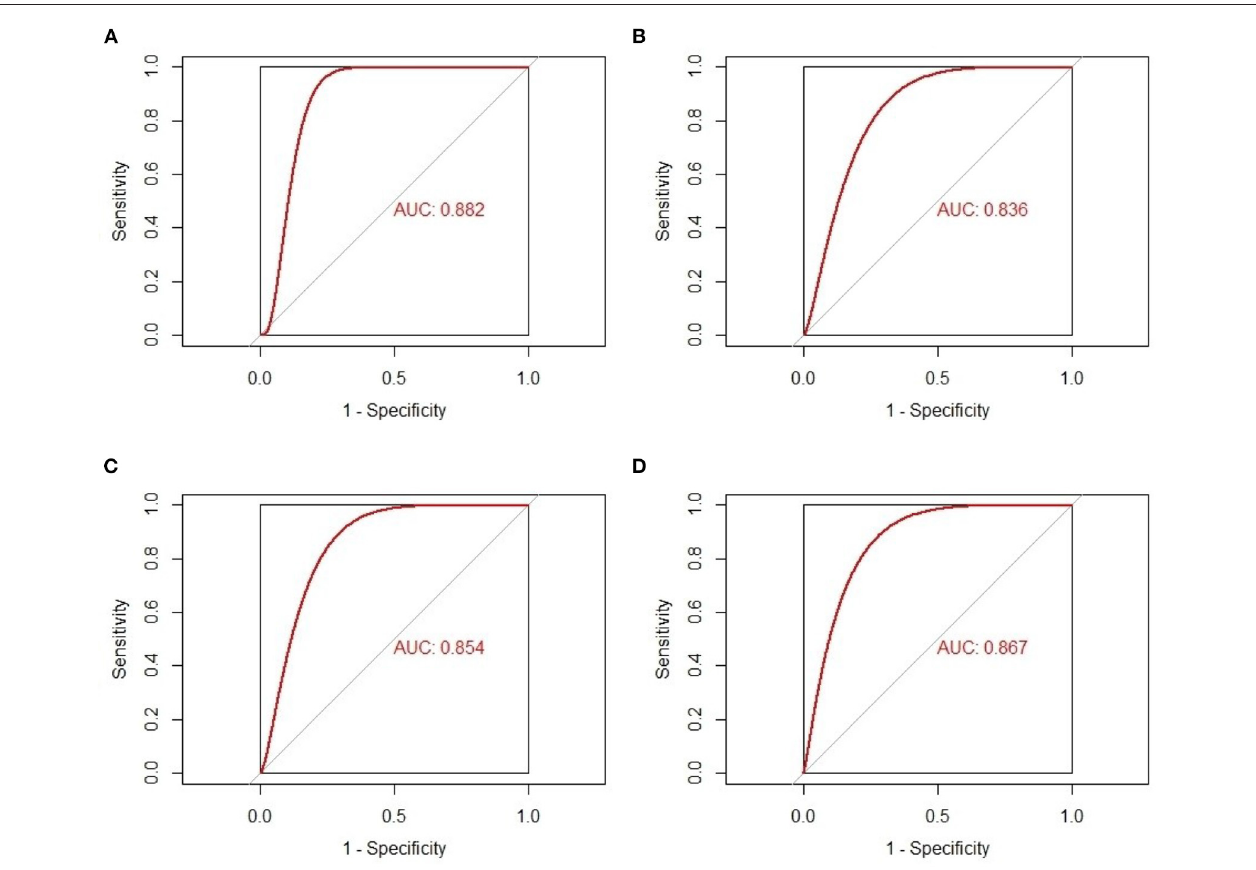
FIGURE 6 | The receiver-operating characteristic curves of the four-feature immune-related genes as biomarkers of hypertrophic cardiomyopathy. (A) AUC of CYBB in GSE36961. (B) AUC of AGTR1 in GSE36961. (C) AUC of CCR1 in GSE36961. (D) AUC of ACKR3 in